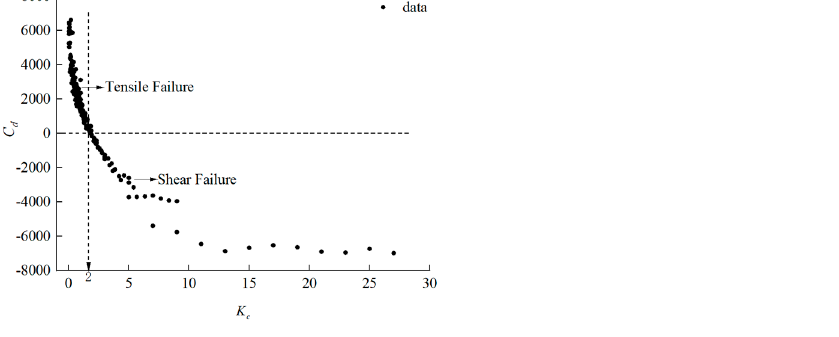
Figure 5. Effects of tensile-shear bond strength ratio on the difference in quantity between tensile and shear cracks.